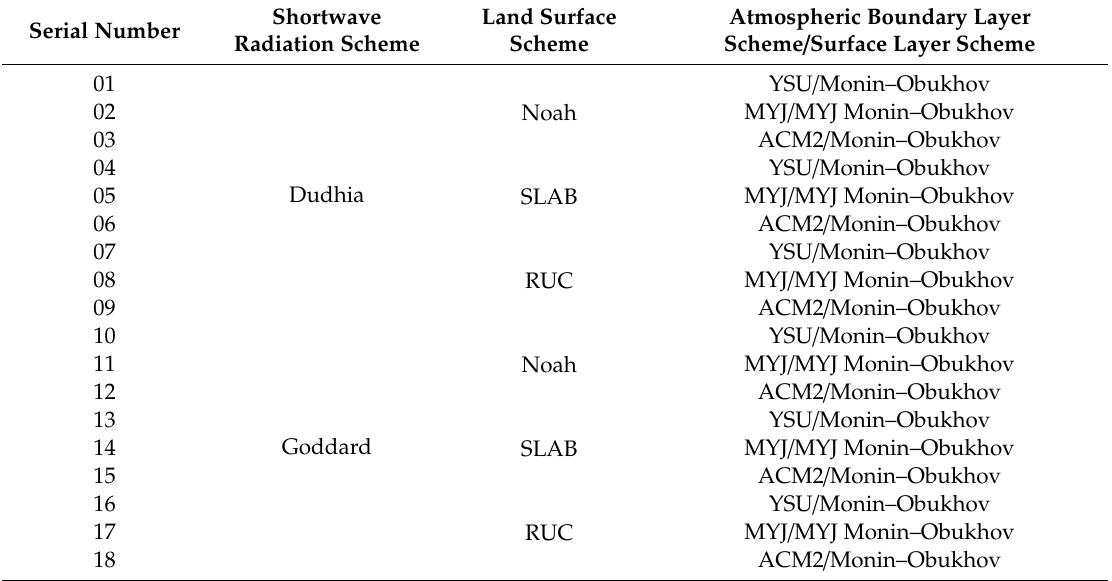
Table 4. Combinations of parameterization schemes for simulation